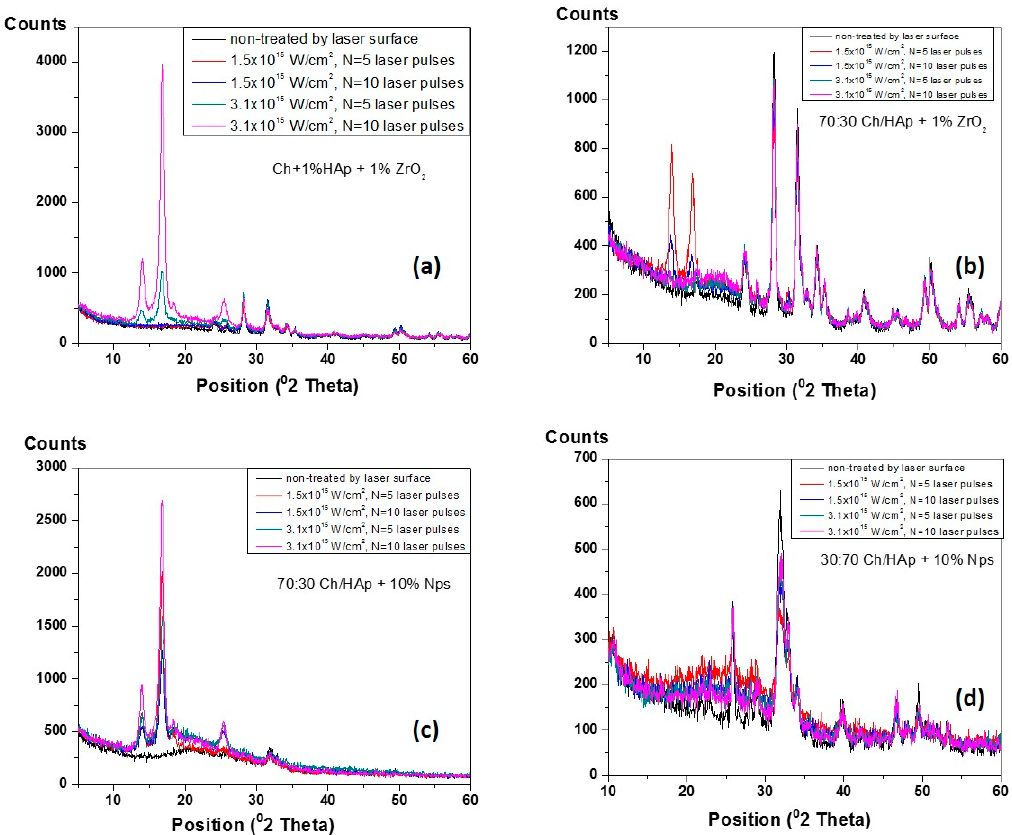
Figure 11. The XRD pattern of diverse composition of chitosan/ceramic blends before and after fs laser treatment. ( a ) Ch + 1% HAp + 1% ZrO 2 ; ( b ) 70:30 Ch/HAp + 1% ZrO 2 ; ( c ) 70:30 Ch/HAp + 10% Nps; ( d ) 30:70 Ch/HAp + 10% Nps.